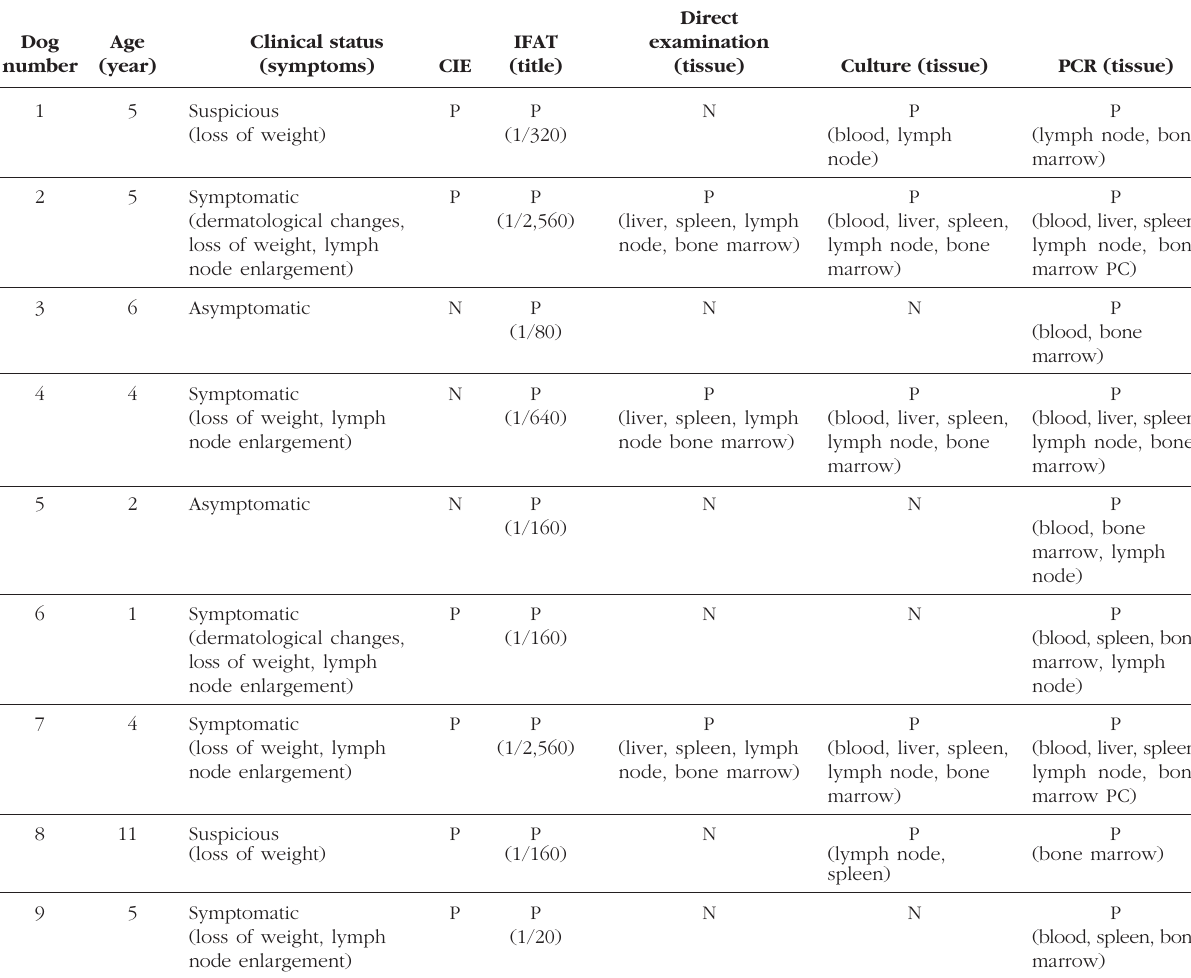
Table II. – Results of serological, parasitological, and molecular methods on sacrificed